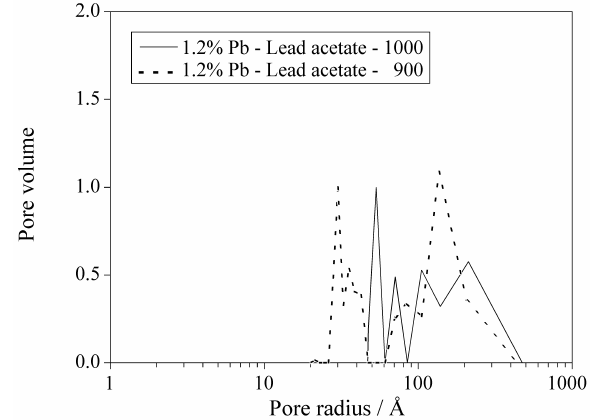
Figure 9. Pore size distribution of gel obtained via lead acetate heat treated at 900 °C and 1000 °C (the weight of the sample was not considered, then volume scale is